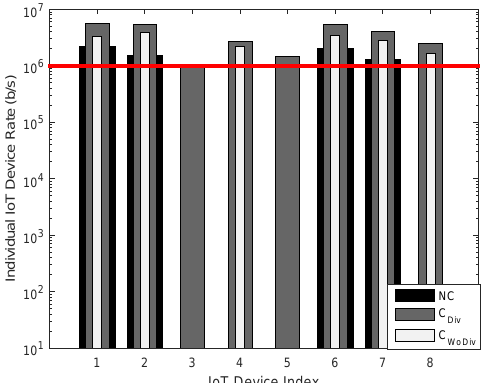
Figure 9. Individual device achieved data rate with respect to different number of total devices, with two relays and minimum device data rate of 1 Mbps.